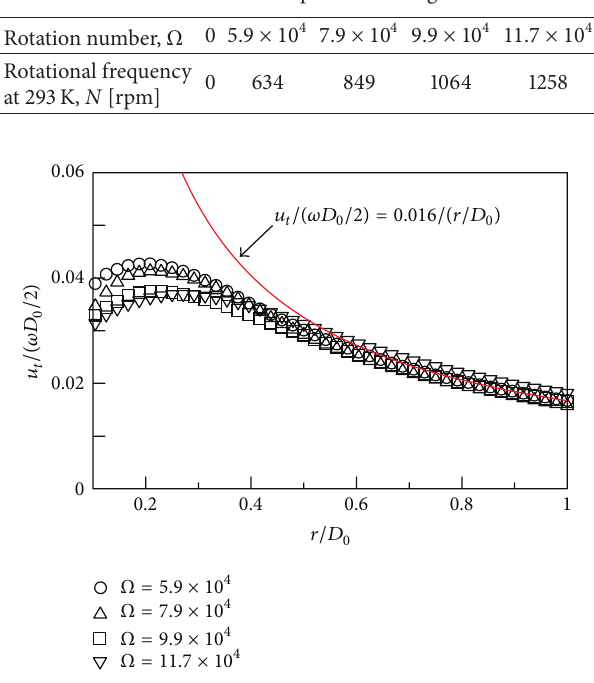
Figure 5: Distribution of circumferential velocity of water at 𝑧/𝐷 0 = = 0 4.17 ( 𝑄 𝑔